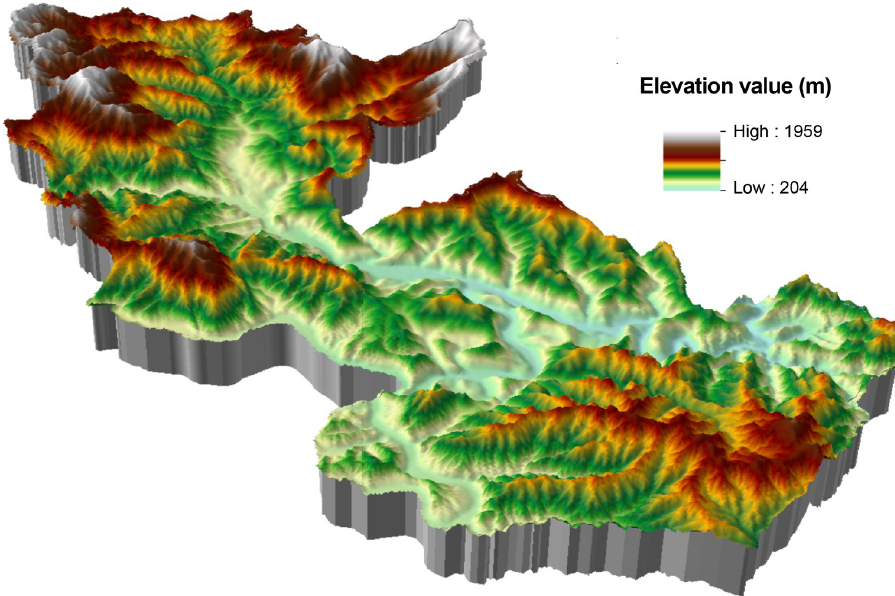
Fig 2. 3D terrain model of the Yesanpo National Park. (Republished from [https://directory.eoportal.org/web/ eoportal/satellite-missions/g/gaofen-2] under a CC BY license, with permission from [Hebei Zhongke Sino Star Information Technology Co., Ltd], original copyright